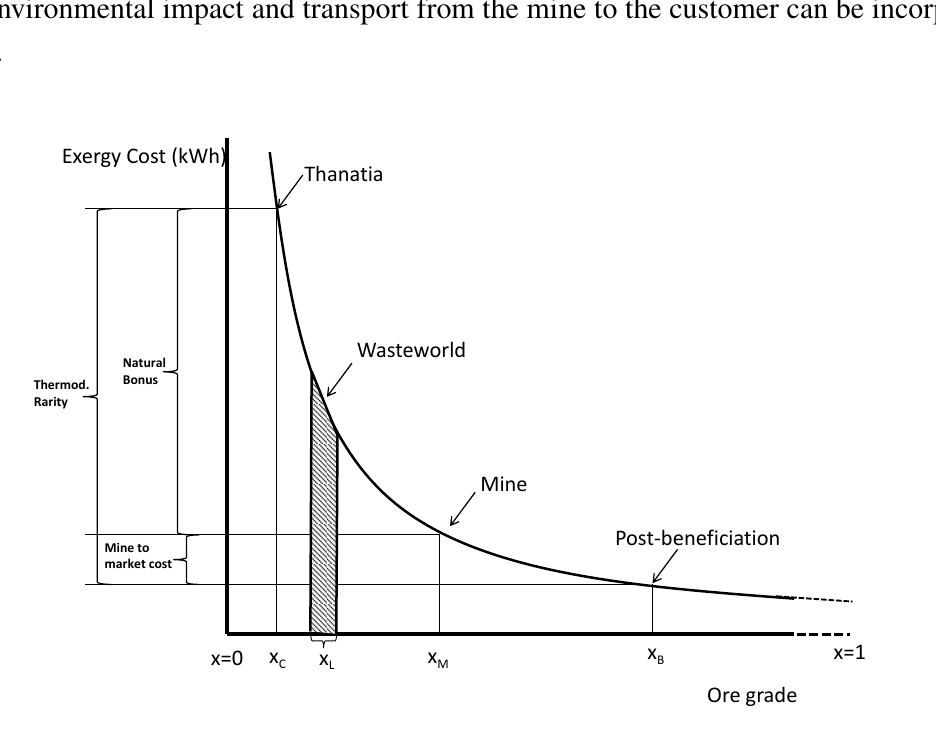
Figure 3. Thermodynamic rarity represents the exergy cost (kWh) needed for producing a given mineral commodity from bare rock to market, i.e ., from Thanatia to the mine and then to post